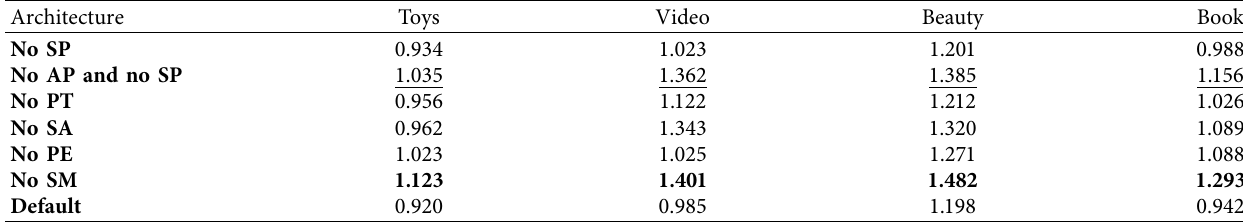
Table 4: Comparison of the model variants for the Toys, Video, Beauty, and Book datasets. Architecture Toys Video Beauty